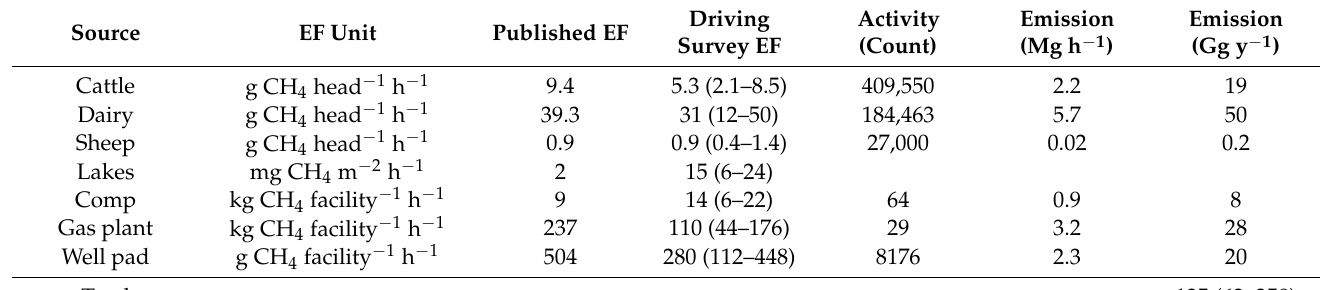
Table 2. Comparison of emission factors (EFs) for sources in the Denver–Julesburg basin as calculated from individual measurement campaigns (Published EF) and those generated by this study (Observed EF). N.B. “Comp” denotes compressor